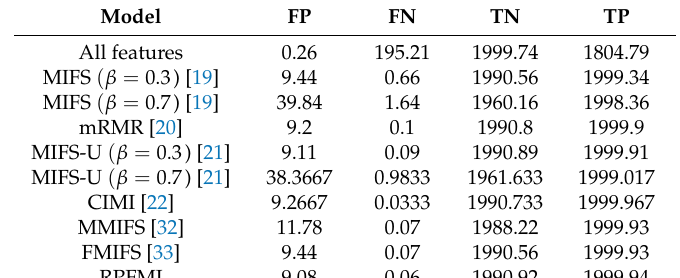
Table 6. Confusion matrices in different models using the DOS test data.